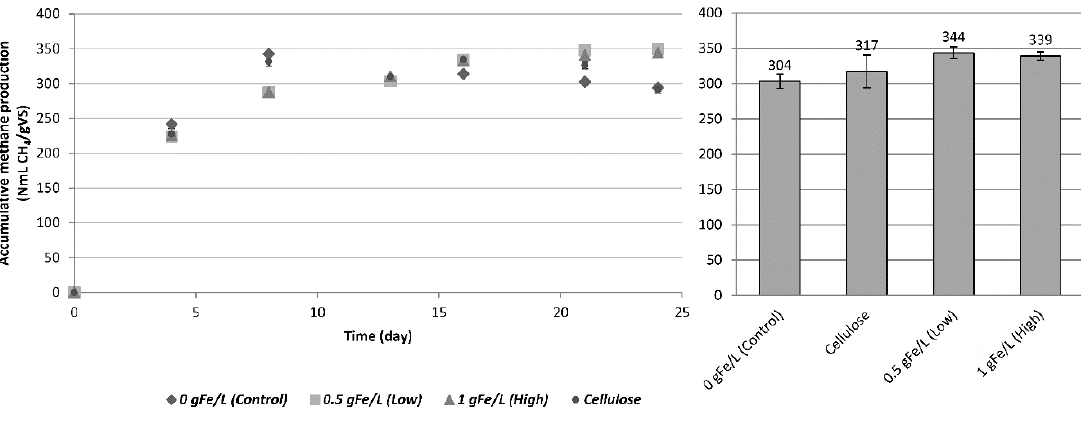
Figure 2. The bio-methane potential from the batch experiment for high and low doses of ochre as well as control reactor (no ochre was added). The average values of BMP presented in the figure above ( right ) are based on the last three measurements from the tests shown to the left.